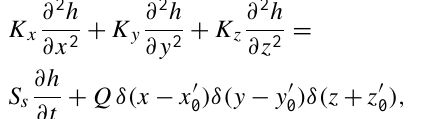
Figure 1. Schematic diagram of a radial collector well in a rectan- gular unconfined